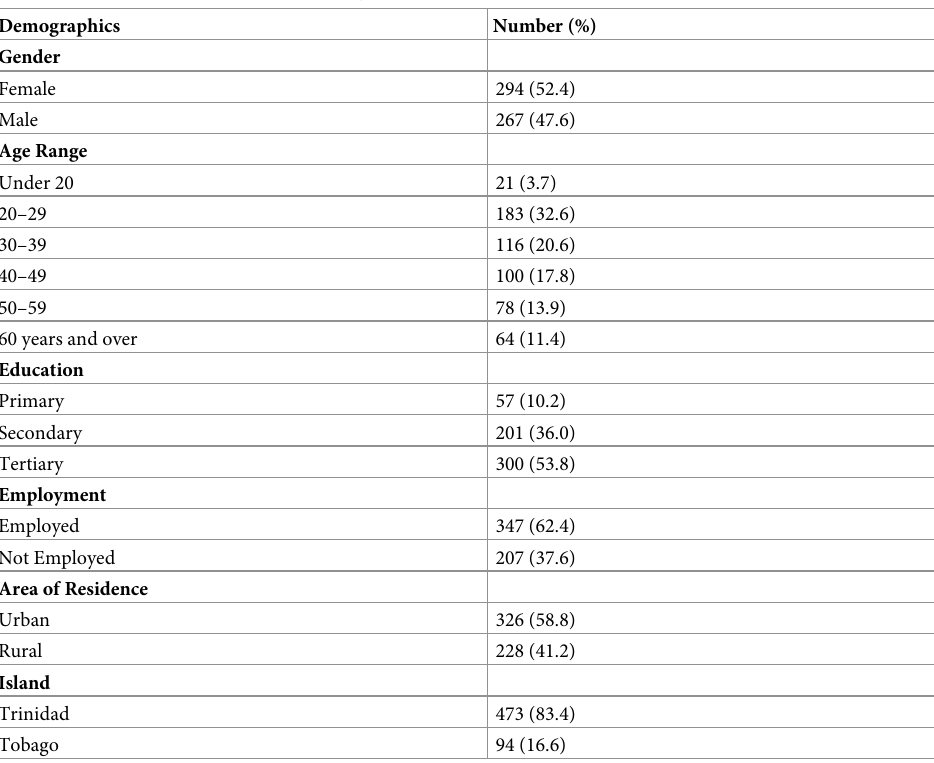
Table 1. Socio-demographic traits used to assess the Knowledge, Attitudes and Practices of respondents regarding sharks and shark consumption in Trinidad and Tobago. The number of respondents per demographic may differ from the total number of persons participating in the surveys (N =